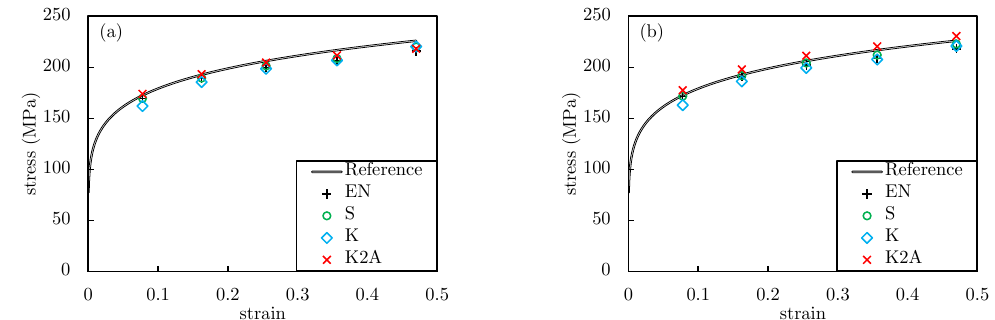
Figure A2. The assigned and A-CPM estimates of the flow stress curve of sample #6. Various estimtes of b A used in A-CPM are developed with a dynamic method for the ( a ) forward and ( b ) backward Euler